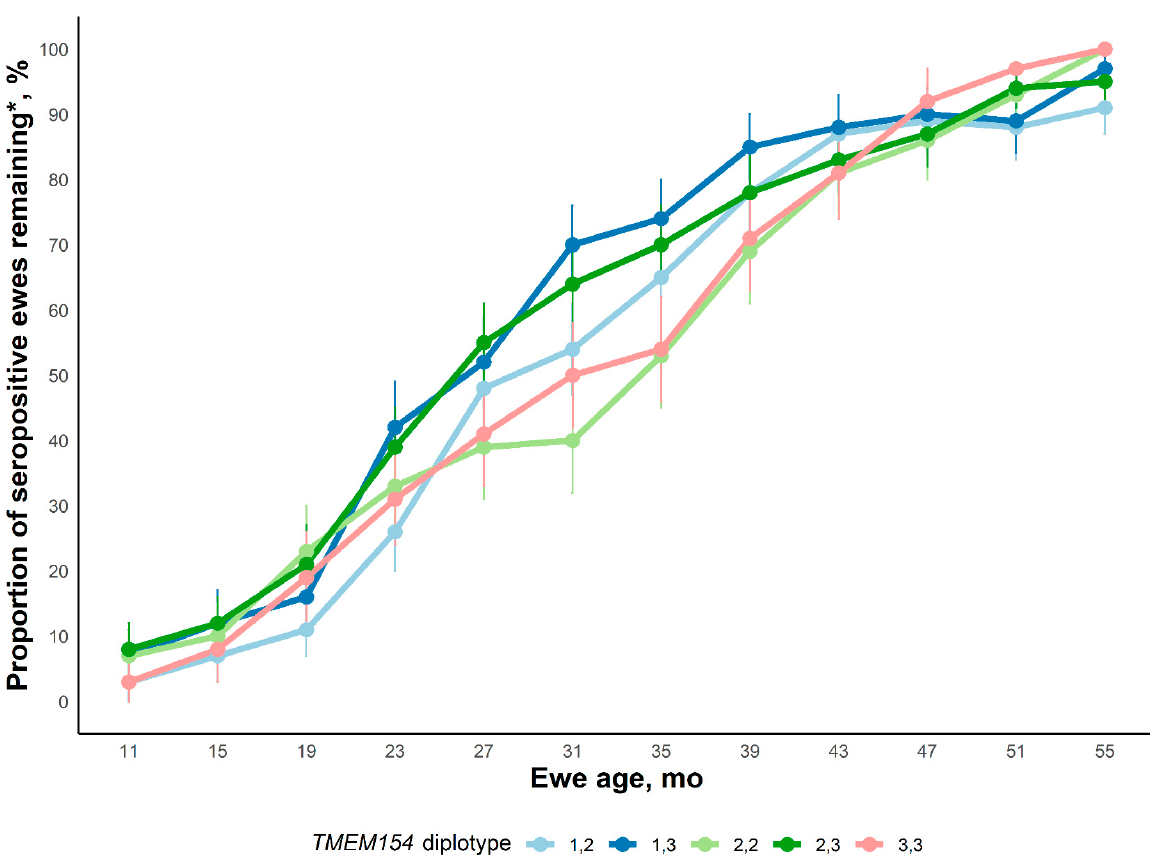
Figure 1. Proportion of ewes in Experimental flock 2 that were serologically positive by age of ewe. Ewes were sampled every 4 months throughout the experiment until three positive tests had been accumulated. Average least square means are presented at approximately each sampling age. The interaction of Age x Diplotype was not significant ( p = 0.94). The main effect of Diplotype was also not significant ( p = 0.84). The main effect of ewe age was significant ( p < 0.001). * Since ewes were culled from the flock for welfare reasons, the apparent seroprevalence can decrease on a percentage basis within a Diplotype group between time points measured.